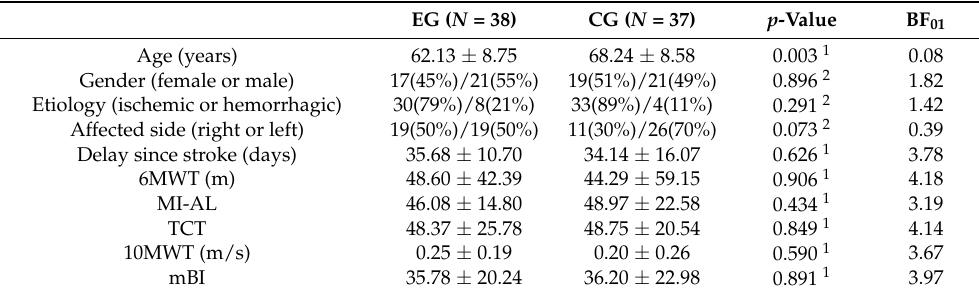
Table 1. Demographic and clinical characteristics of the sample at T1.